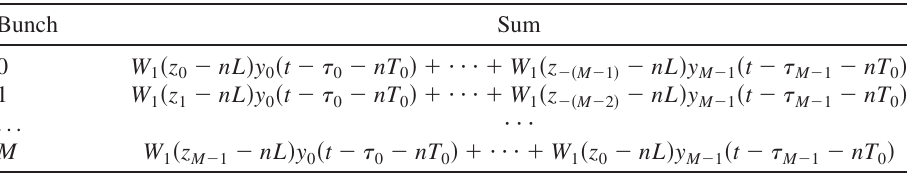
TABLE V. Convolution of displacements and wake functions in the n th turn of history.